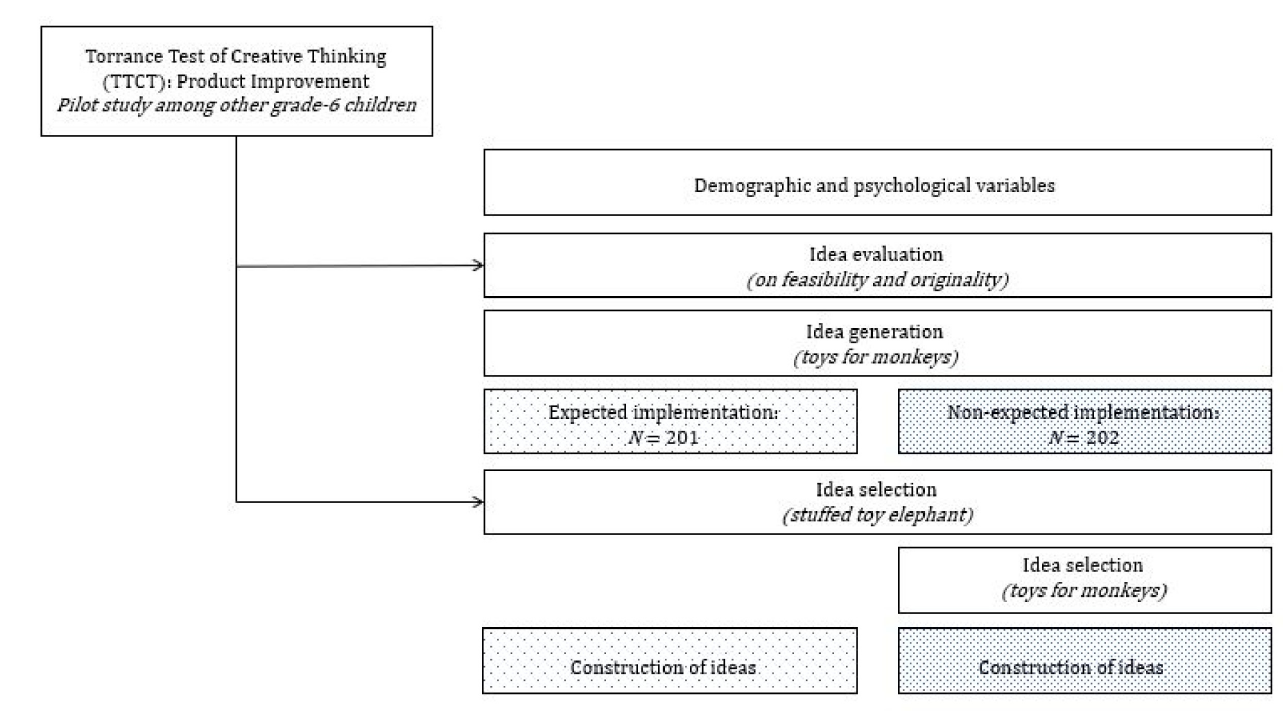
Fig 1. The experimental